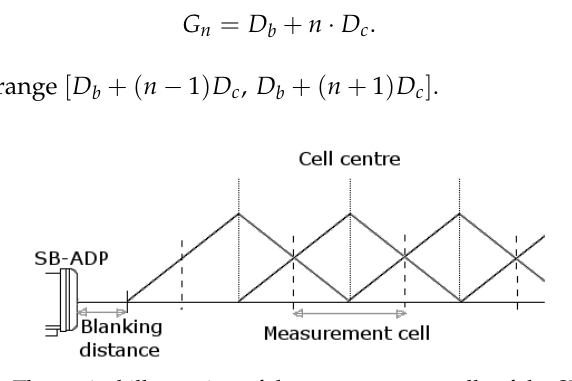
Figure 3. Theoretical illustration of the measurement cells of the